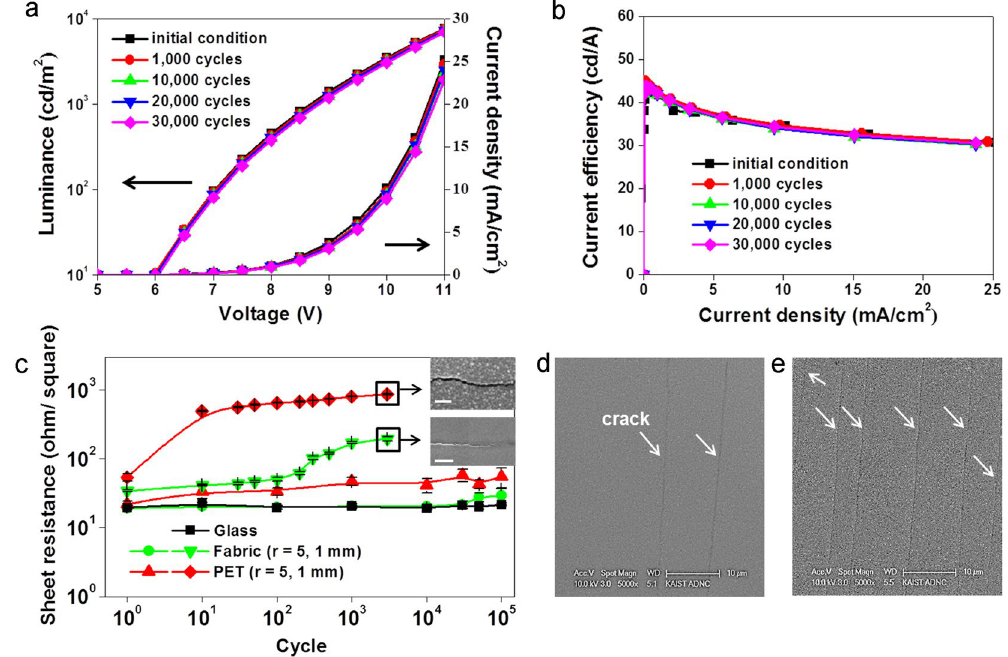
Figure 6. Bending fatigue: ( a,b ) Deviations of the electrical-optical performance capabilities according to the number of bends, ( a ) J-V-L characteristics, and ( b ) current efficiency. ( c ) Deviations in the sheet resistance of 100-nm-thick aluminum according to the bending strain and number of cycles (scale bars: 1 μ m). ( d,e ) SEM image of Al on ( d ) the fabric, and ( e ) PET after bending with a bending radius of 1 mm at 3,000